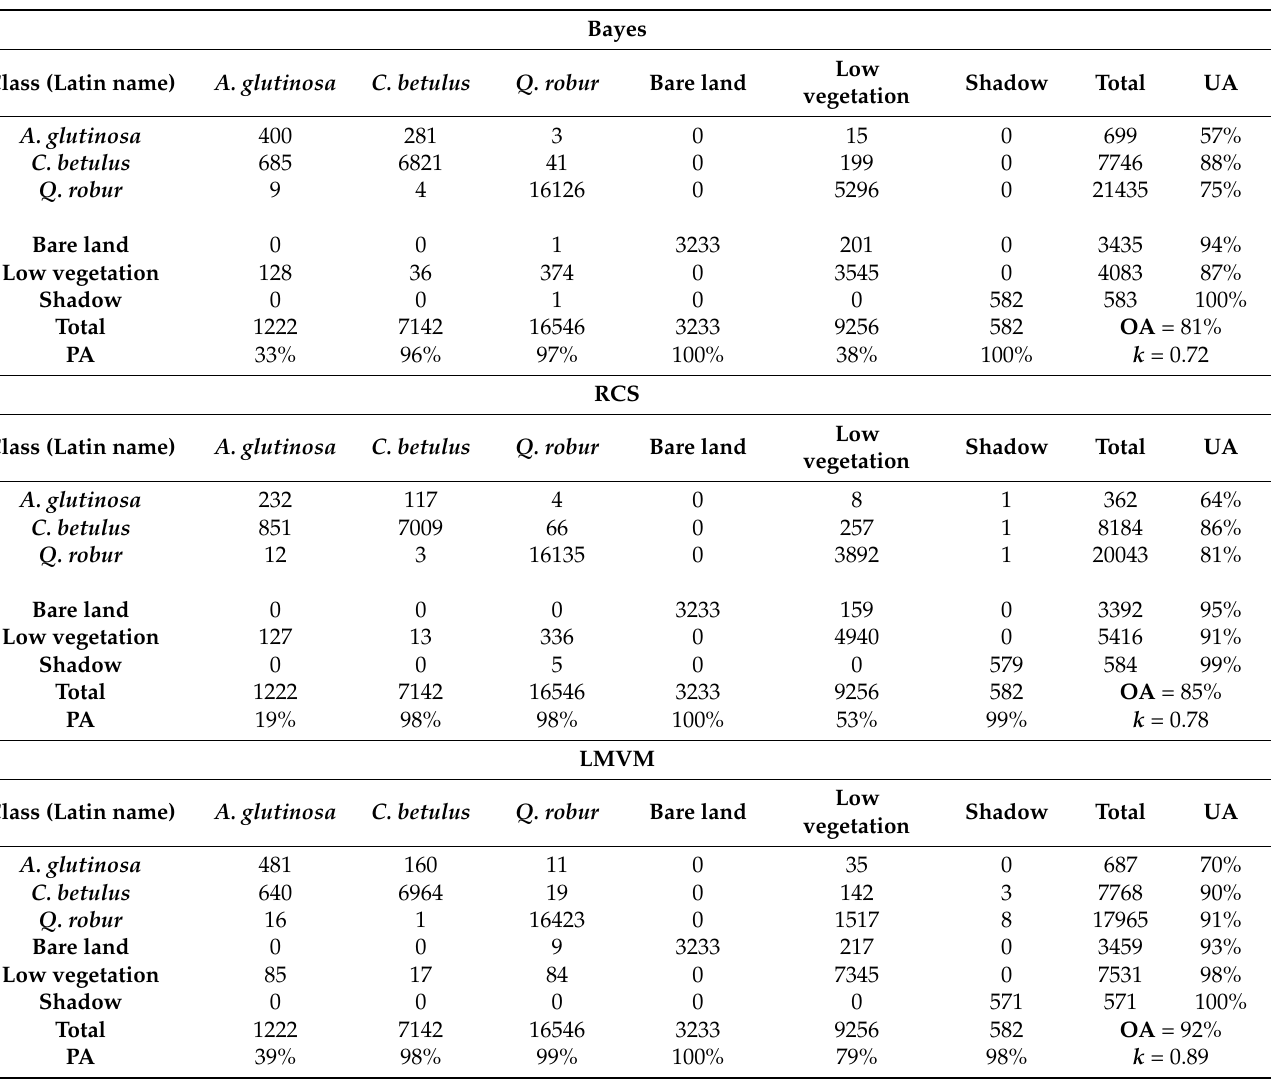
Table 2. Accuracy assessment of pixel-based classification of the pansharpened imageries (Bayes, RCS, LMVM) performed on 136 validation polygons.